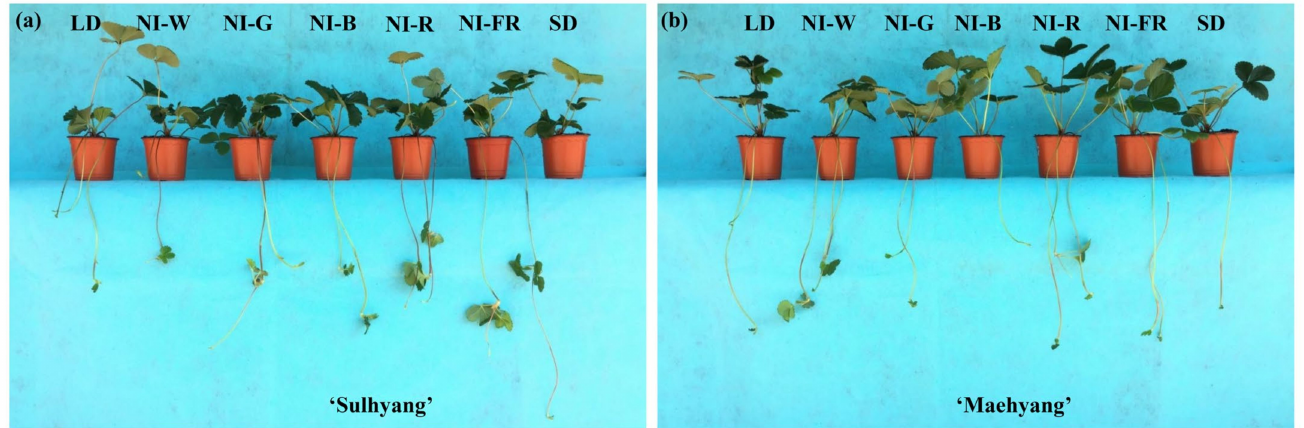
Figure 3. The morphology of ‘Sulhyang’ ( a ) and ‘Maehyang’ ( b ) strawberries as affected by night interruption (NI) light: LD, long day; SD, short day; W, white; G, green; B, blue; R, red; and FR,